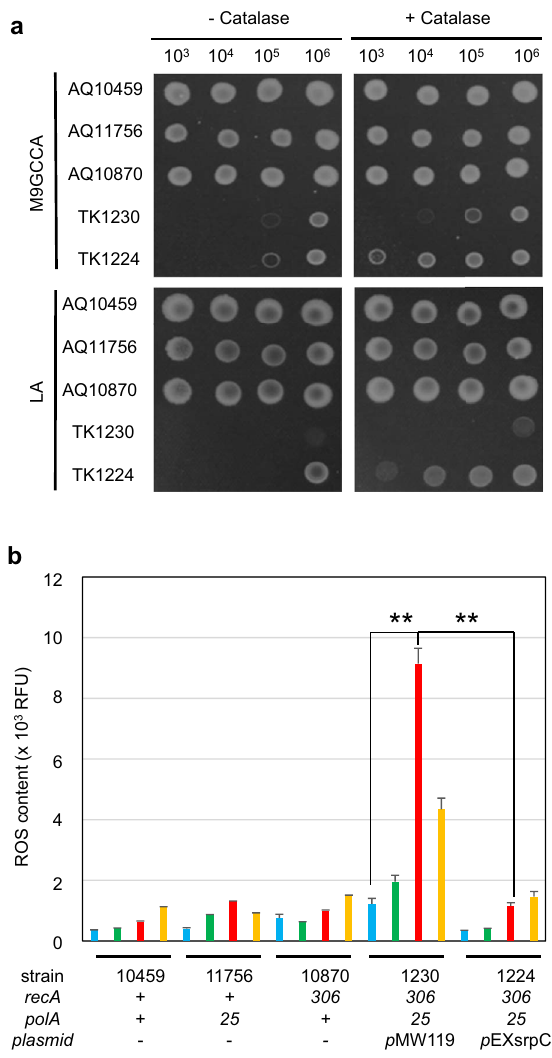
Figure 7. Effect of catalase on L medium sensitivity in ΔrecA306 polA25 cells. ( a ) Effect of catalase in ΔrecA306 polA25 cells growing on plate medium. TK1230 ( ΔrecA306 polA p vec) or TK1224 ( ΔrecA306 polA p EXsrpC) cells were fully grown in M9GCAA medium and subsequently diluted with M9B to contain the indicated number of cell particles. Then, 2 μL of diluted cells were spotted on L plates and incubated at 30 °C for 30 h. The images are shown from top to bottom: M9GCAA and L plate medium; right to left: no catalase and 1000 U/mL, respectively, at 30 °C. ( b ) Effect of catalase on ROS accumulation in ΔrecA polA cells. The cells shown in ( a ) were recovered and stained with SYBR Green I and CellRox Deep Red. Nucleic acid-containing E. coli particles were selected from the double-stained samples and analysed using histograms. Each histogram was as follows: blue, M9GCAA without catalase; green, M9GCAA with catalase; red, L without catalase; orange, L with catalase. Each bar represents the mean ± SEM (n ≥ 4). Double asterisks indicate significant differences ( p < 0.01) as analysed using Welch’s t tests (n =